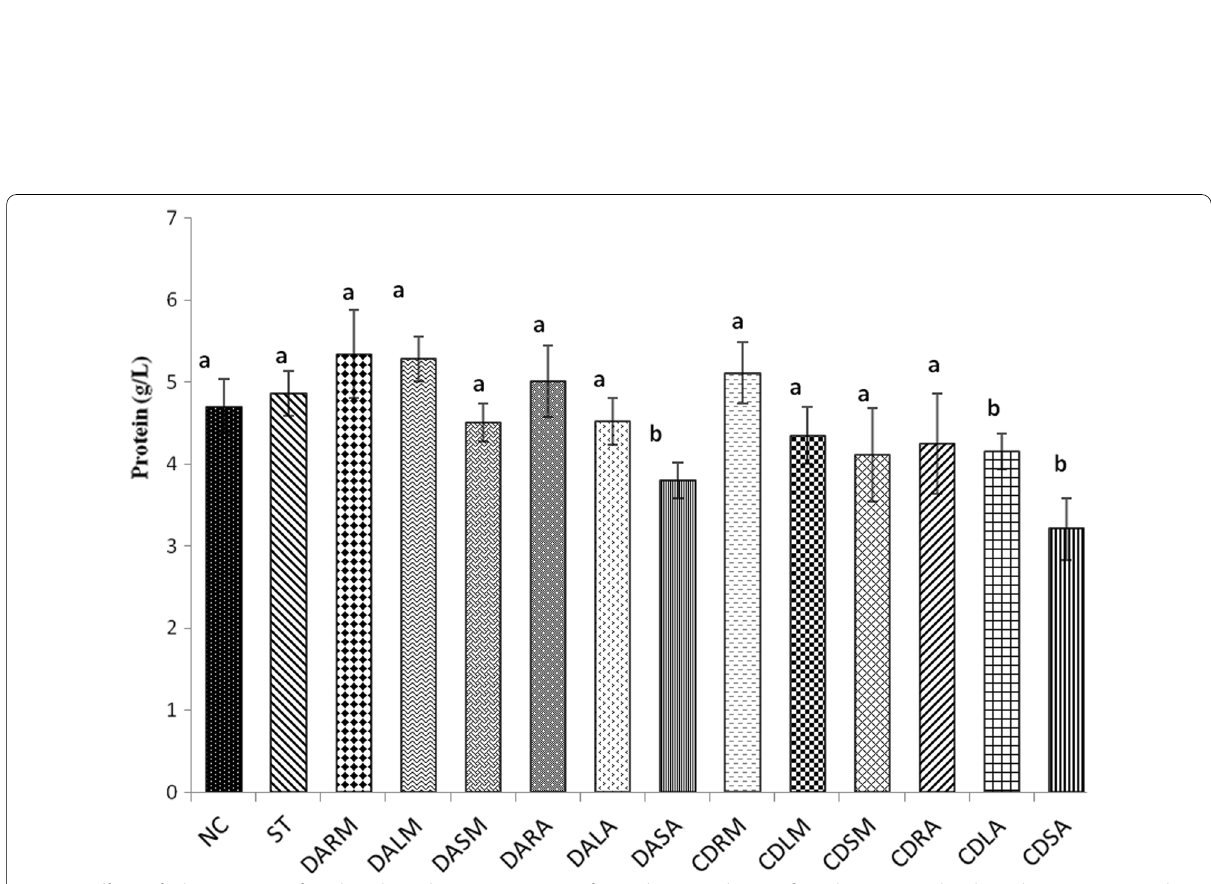
Fig. 12 Effects of administration of methanolic and aqueous extracts of roots, leaves and stem of D.arborescens and C. dependens on serum albumin of rats. Bars with similar alphabets are not statistically different ( p < 0.05)